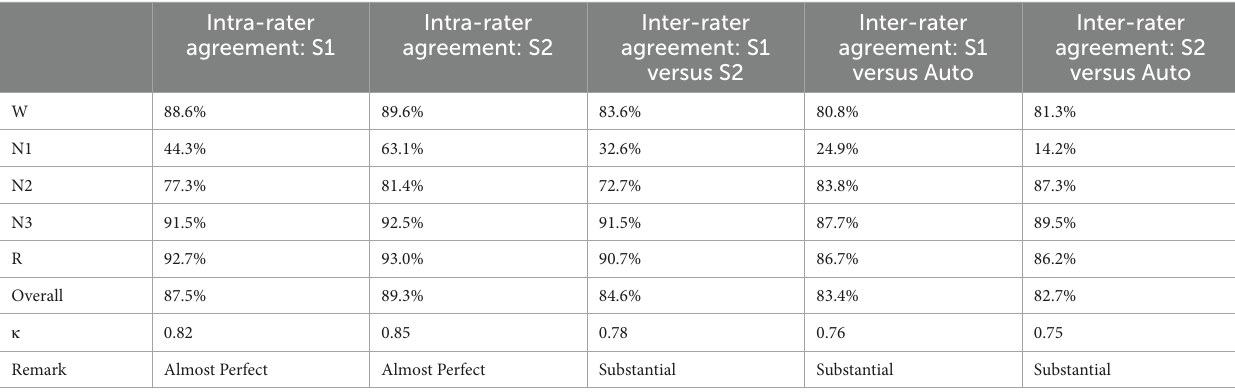
TABLE 4 Intra-rater and inter-rater reliability metrics for individual and overall sleep stage comparisons between manual scorers and the automatic method in a holdout subset of n = 10 (i.e., the comparison